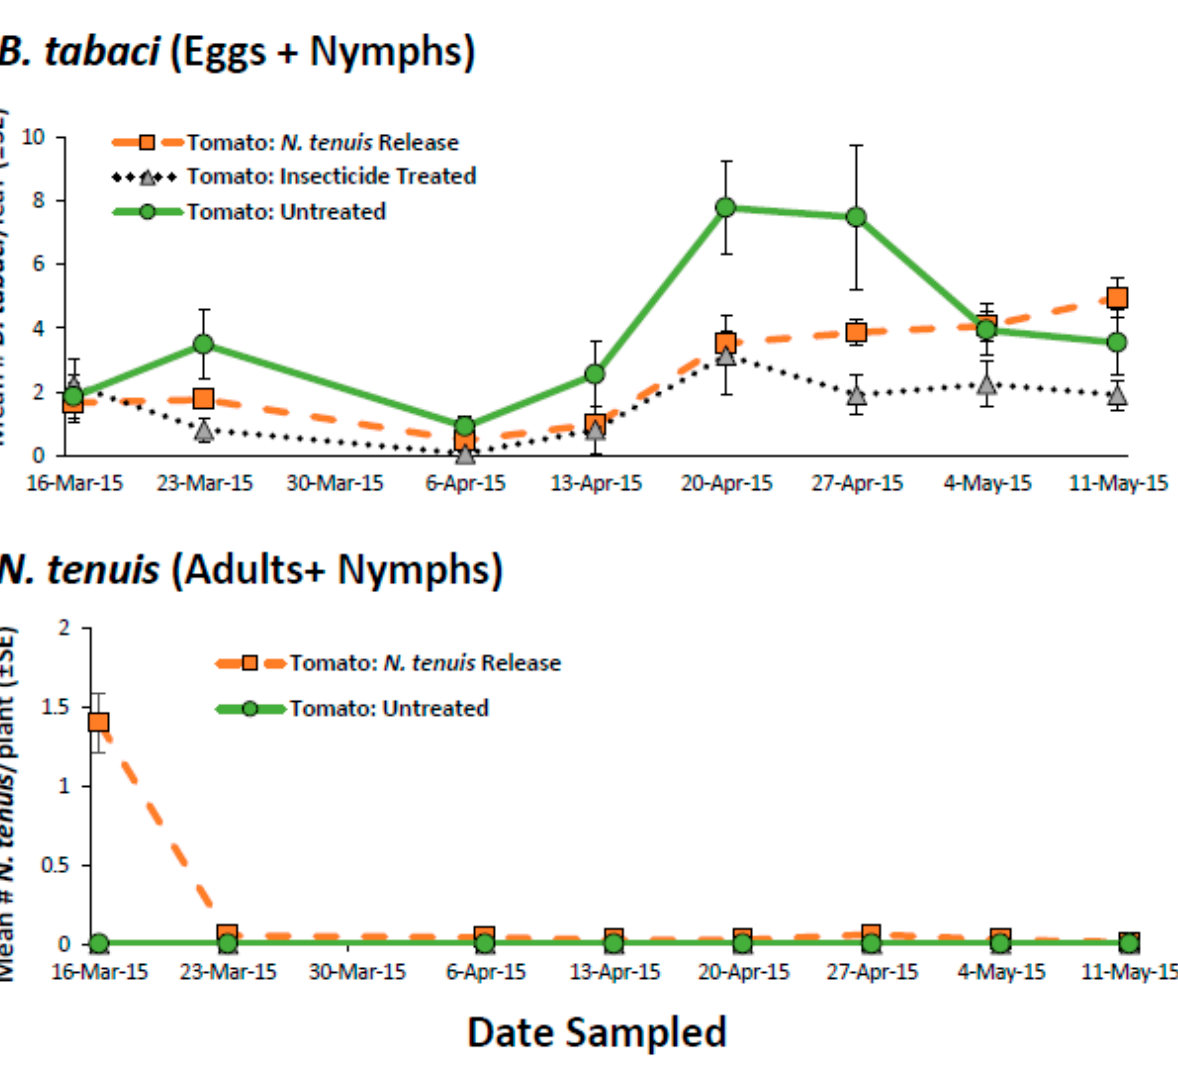
Figure 1. The field plot layout ( A ), the mean (±SE) number of B. tabaci (eggs + nymphs) per leaflet ( B ), and the mean (±SE) number of N. tenuis (adults + nymphs) per tomato plant ( C ) in a study that compared the ability of N. tenuis to control B. tabaci to insecticides (imidacloprid). The number under each field plot treatment (A) indicates the number of tomato plants.